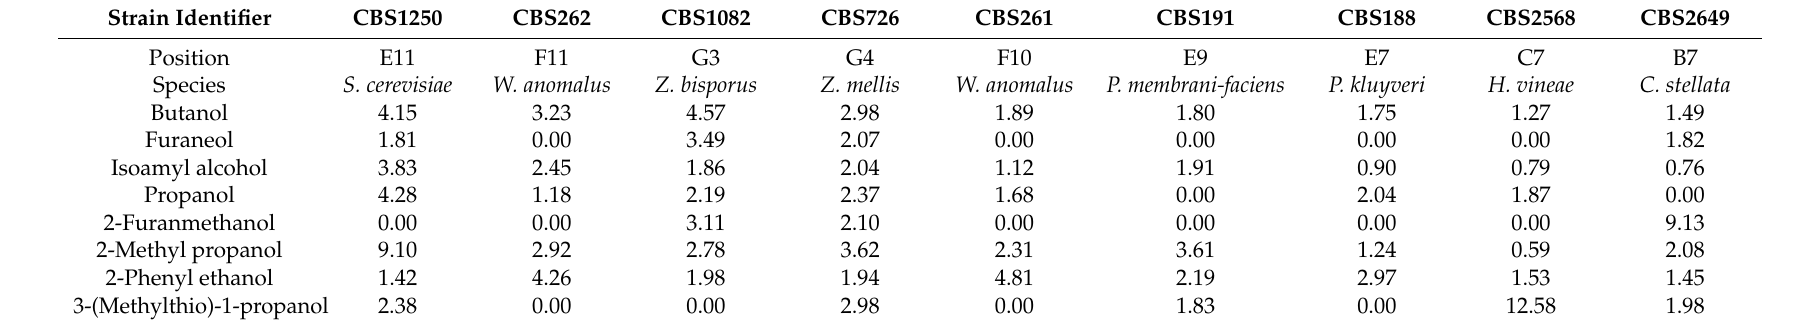
Table 3. Strains with higher aroma alcohol production than the Weihenstephan lager yeast